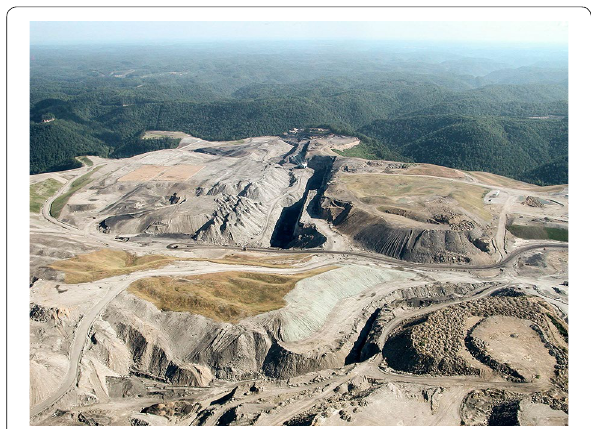
Fig. 3 Kayford mountain during MTR operations. Photo: Vivian Stockman with the Ohio Valley Environmental Coalition; Flyover courtesy